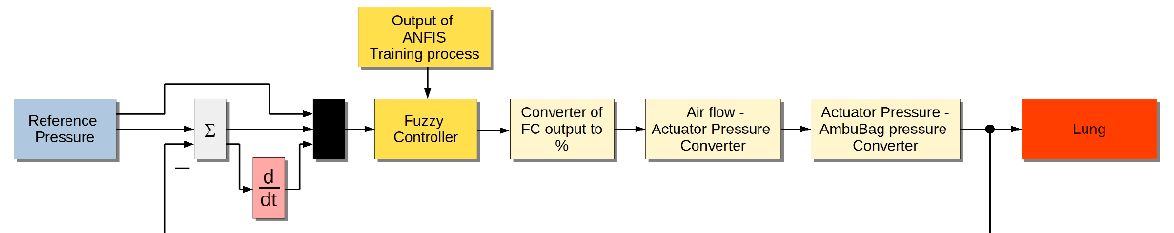
Figure 21. Simulation model of mechanical ventilation for RPT mode.